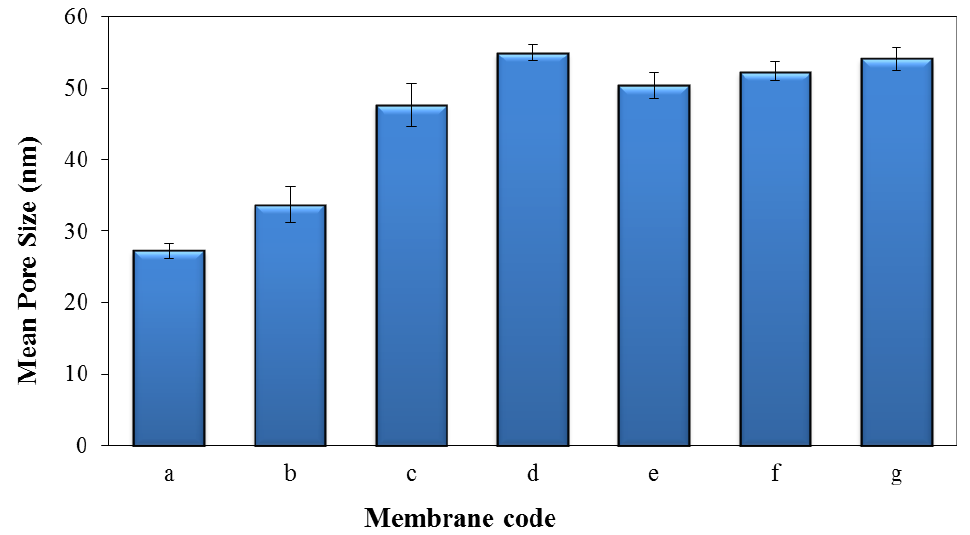
Figure 7. The mean pore size of PES/PTGM membranes.